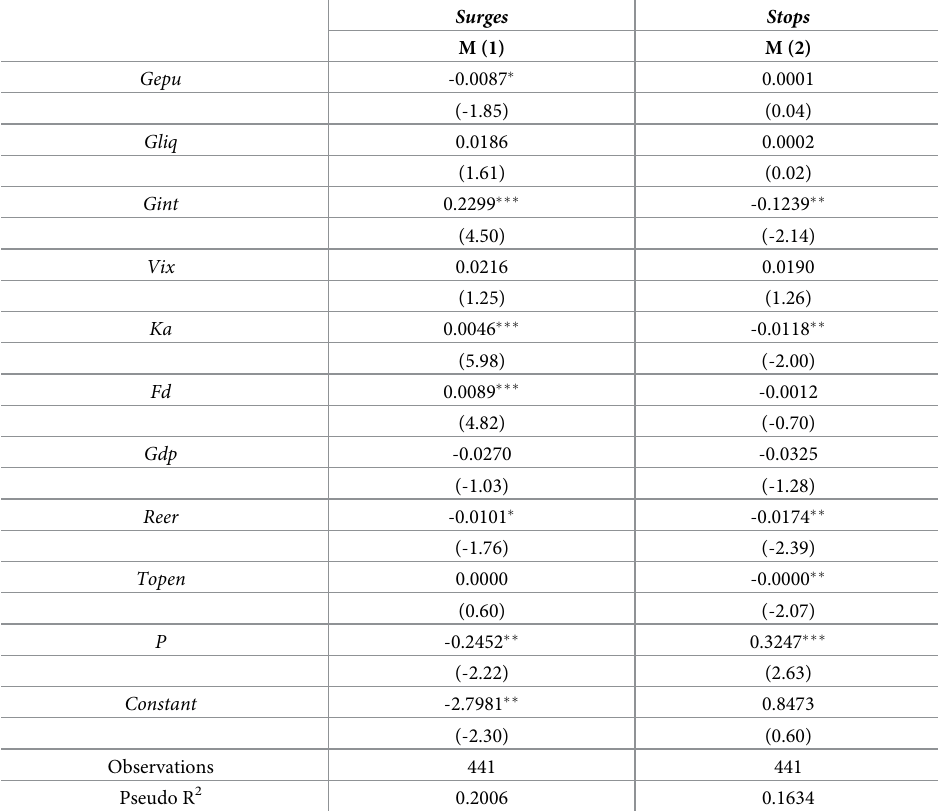
Table 13. Impact of Gepu on extreme international capital inflows episodes in developed